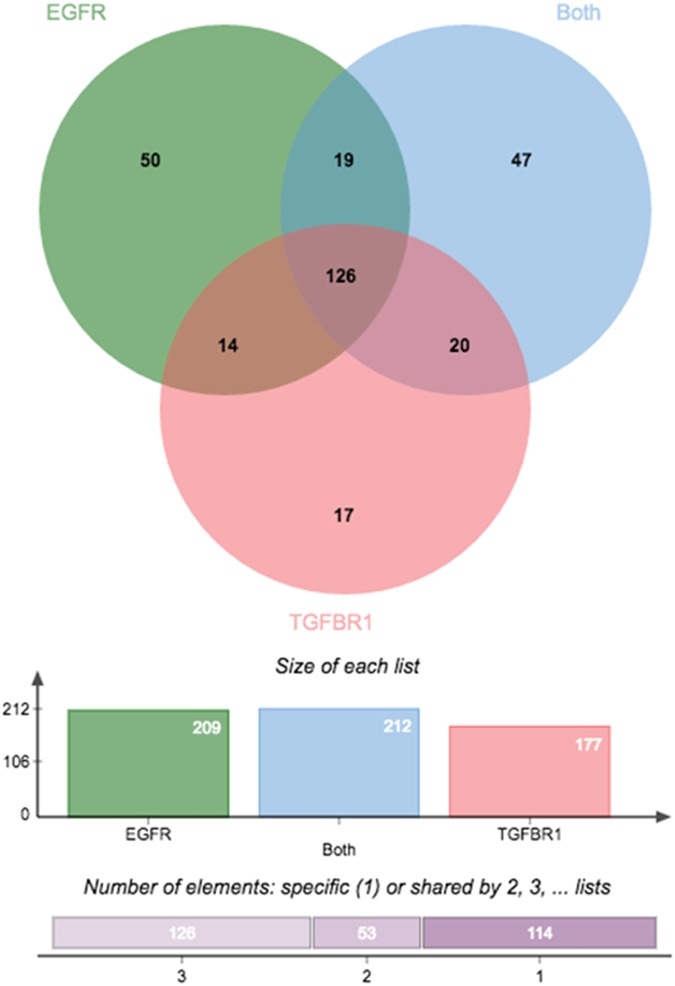
Depicted is the Venn diagram showing the differentially expressed genes of each of the treatments.Thrombin transactivation of the EGFR (209 genes), thrombin transactivation of the TGFBR1 (177 genes) and thrombin transactivation of both EGFR and TGFBR1 (212 genes).